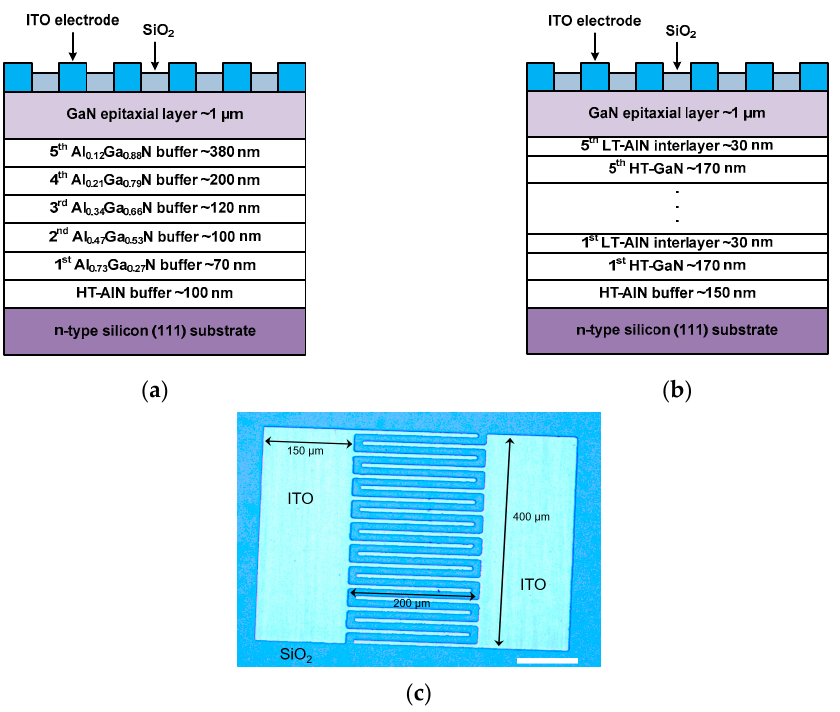
Figure 1. Schematic cross-sectional views of GaN metal-semiconductor-metal (MSM) UV photodetectors showing epitaxial layer structures with different buffer layers and top view image of the fabricated UV photodetector. ( a ) Epitaxial layer structure with a step-graded Al x Ga 1 − x N buffer layer and ( b ) epitaxial layer structure with a conventionally-used high-temperature(HT)-GaN/low-temperature(LT)-AlN buffer layer; ( c ) Optical image of the GaN MSM UV photodetector. The design of Schottky electrode structure was identical for both types of devices. The thickness of the GaN active layer, material for the Schottky contact, and device fabrication process for both devices were also the same.